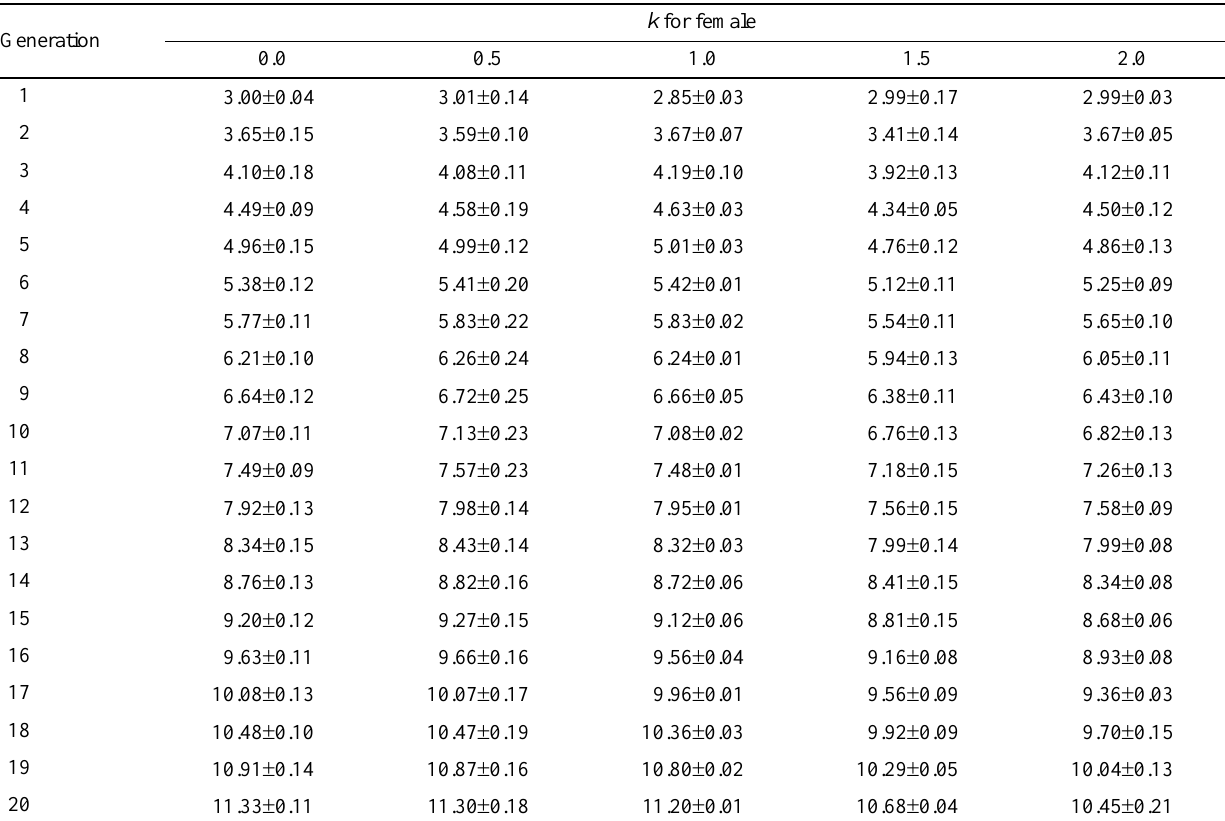
Table 4. Changes of average breeding values and standard deviations in male with different k values for female when k for male = 0